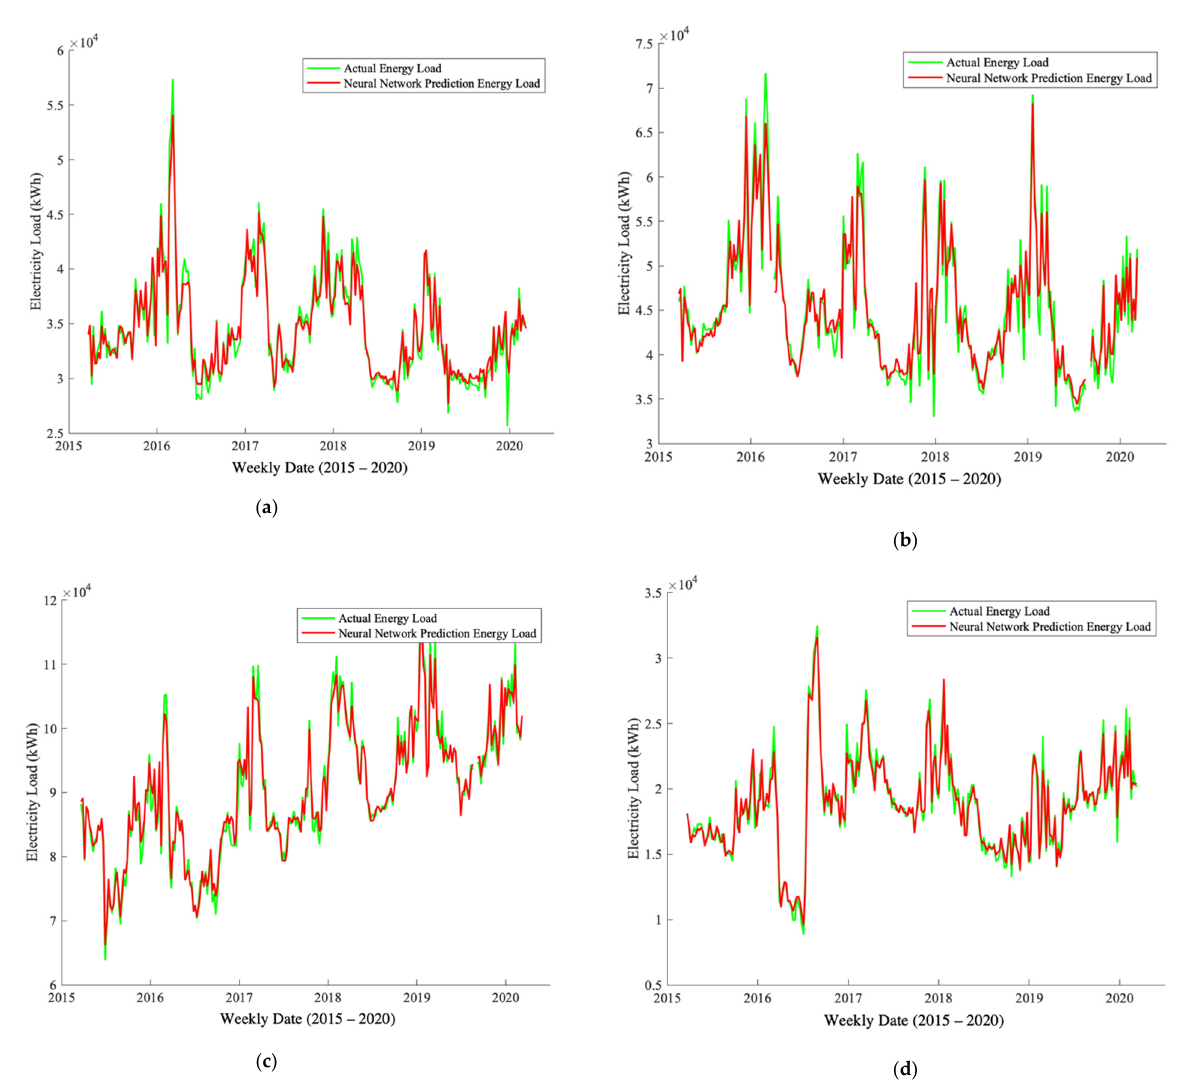
Figure 6. The NARX network prediction vs. actual electricity load for all buildings. ( a ) B1, ( b ) B2, ( c ) B3, and ( d ) B4.